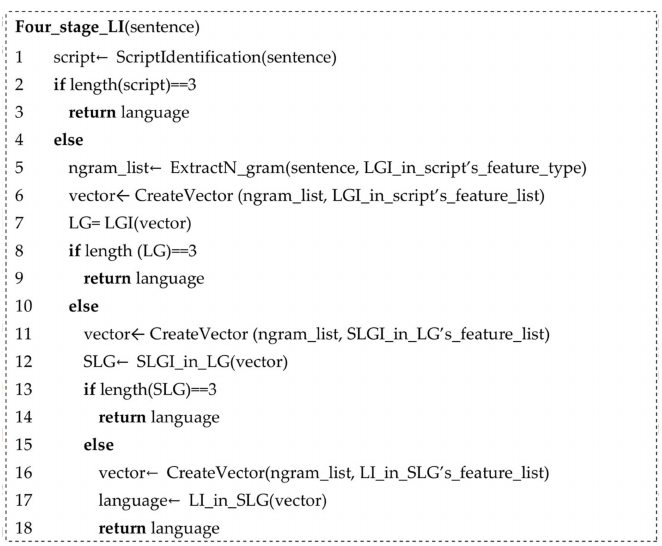
Figure 4. Pseudocode of four-stage LI.